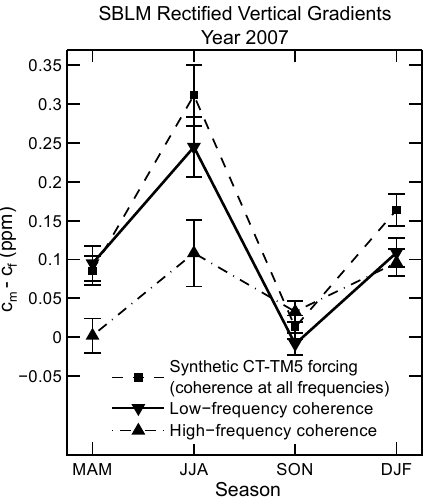
Fig. 8. Rectified vertical CO 2 gradients predicted by SBLM with synthetic forcing fitted to modified cross-spectral densities having the coherence spectra shown in Fig. 7. The modified forcing time series have coherence spectra separated into low frequencies (down- ward triangles) or high frequencies (upward triangles). The unmod- ified forcing time series is shown for reference (dashed line, solid squares) and corresponds to the dashed line in Fig. 5c. Error bars indicate the standard error of the mean over 300 independent real- izations of each season.